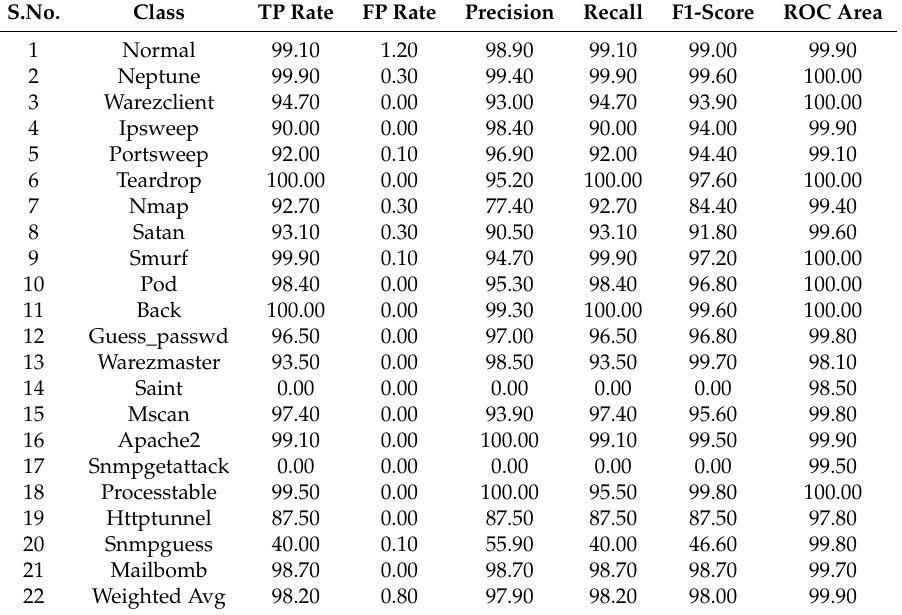
Table 41. Multiclass classification report for NSLKDD using Adaboost